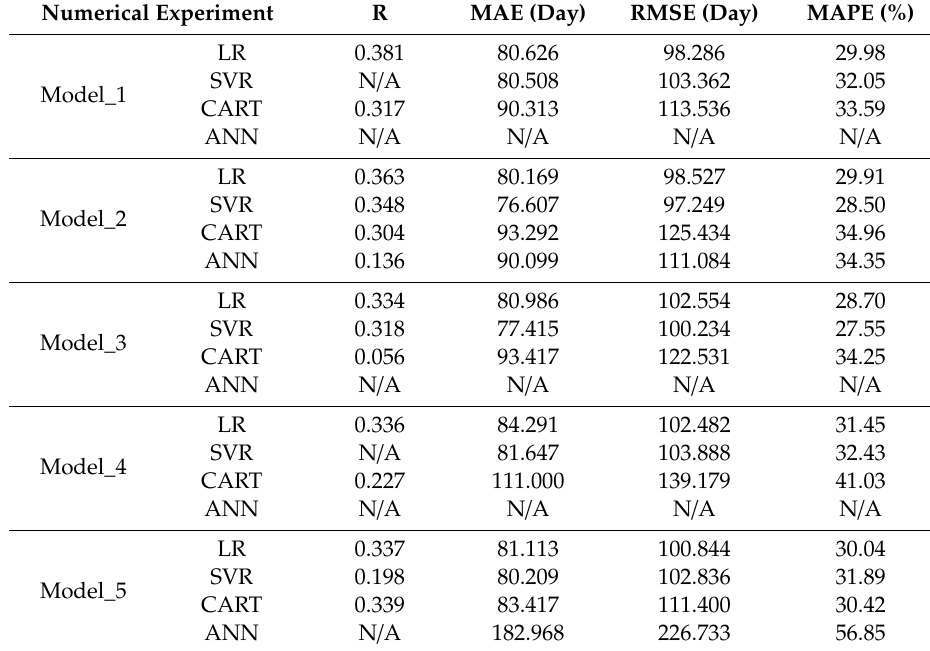
Table 4. Model performance